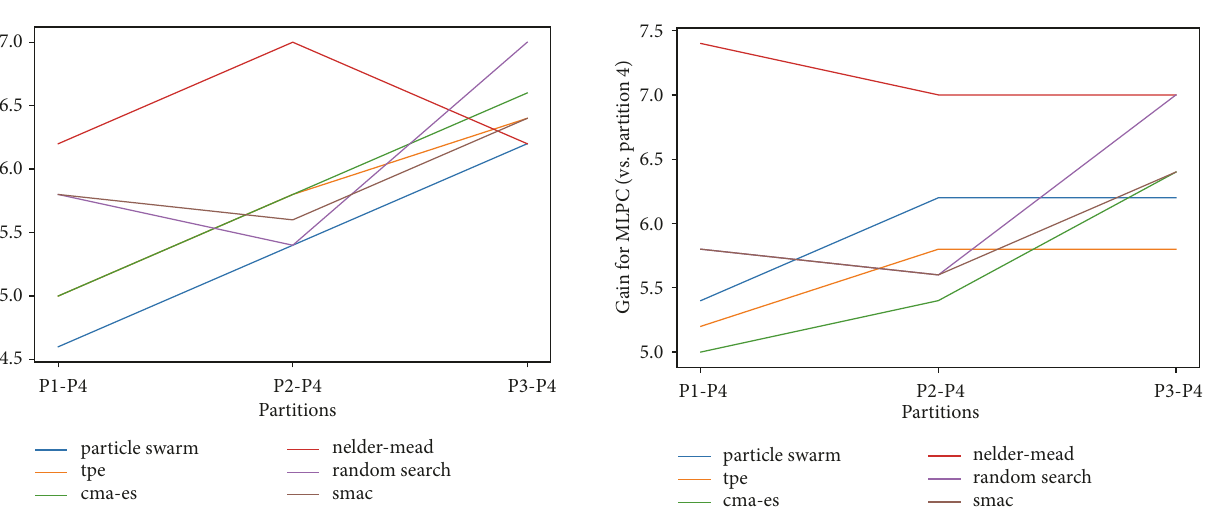
Figure 6: Average of gain for each smaller partition with respect to the whole dataset in MLP.